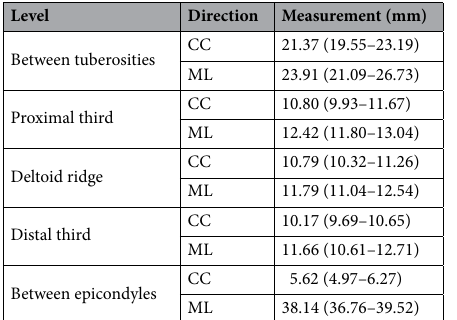
Table 1. Micro-CT measurements of external diameter in both the craniocaudal (CC) and mediolateral (ML) planes of the koala humerus at each of the five measurement levels represented as mean with 95% confidence intervals.